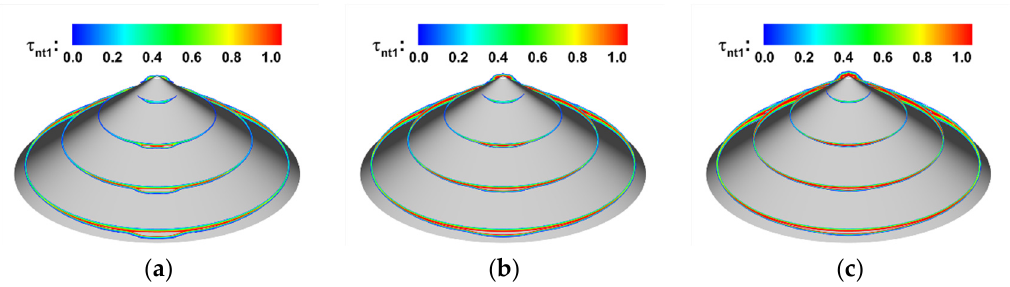
Figure 20. Distribution of the first unstable disturbance on windward surface. ( a ) α = 2°, ( b ) α = 4°, ( c ) α = 6°.